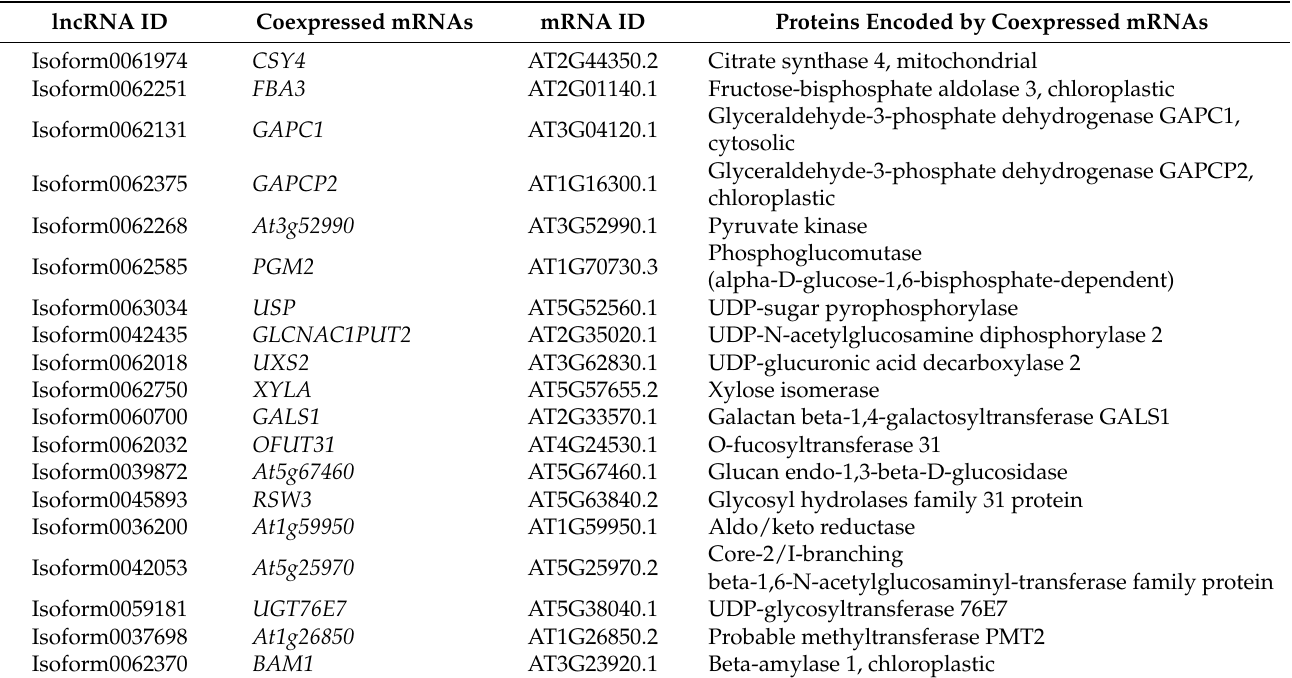
sion levels of five representative coexpressed mRNAs ( CSY4 , GAPCP2 , At3g52990 , PGM2 , and BAM1 ) involved in carbohydrate metabolism were confirmed by qRT-PCR, with all five mRNAs showing down-regulation at T3 vs. T1, and three mRNAs showing higher levels at T2 vs. T1 than T3 vs. T1, with the exception of the two genes GAPCP2 vs. T1, with the exception of the two genes GAPCP2 and BAM1 (Figure 5). and BAM1 (Figure 5). Table 5. Nineteen lncRNAs directly linked with carbohydrate Table 5. Nineteen lncRNAs directly linked with carbohydrate metabolism.